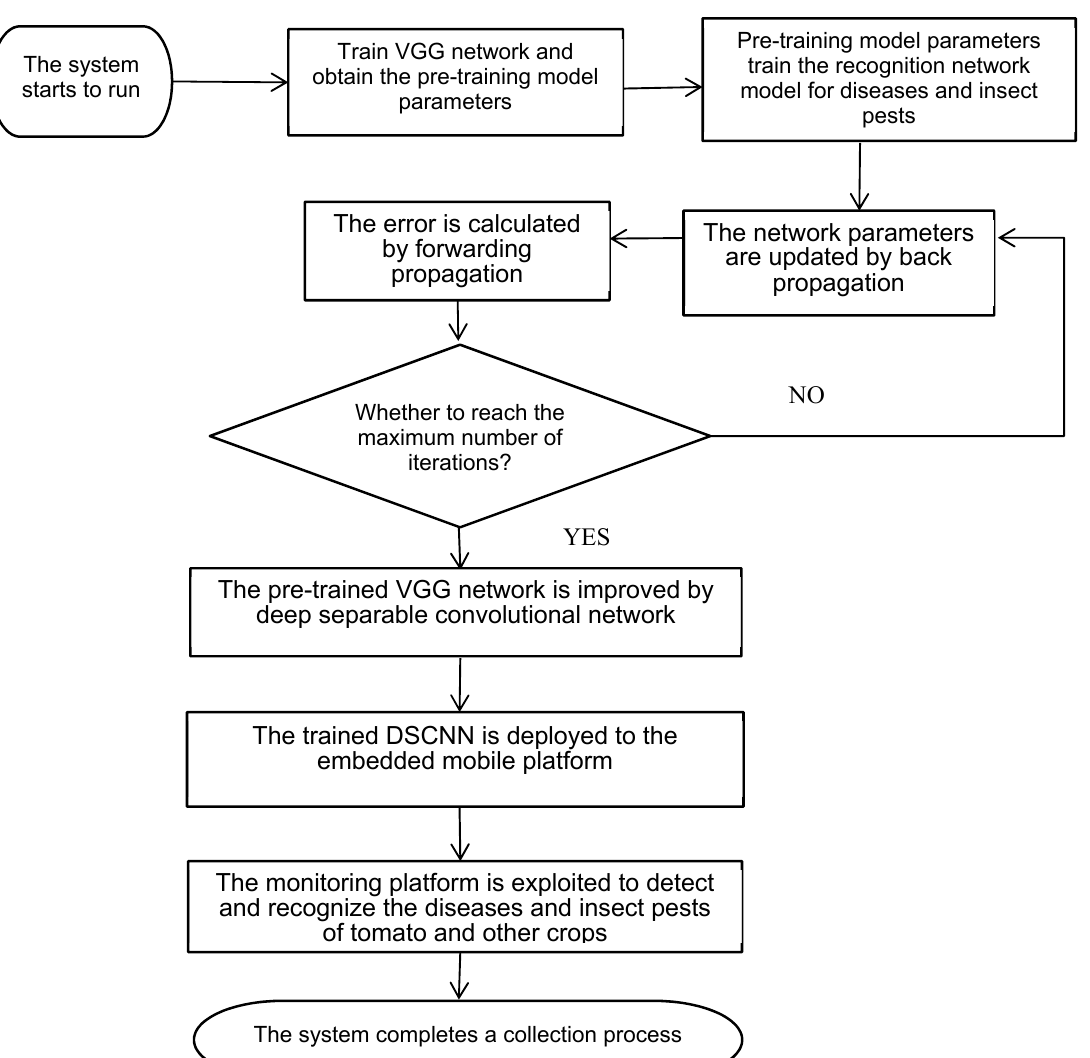
Figure 6. Crop diseases and insect pests detection system flow chart.